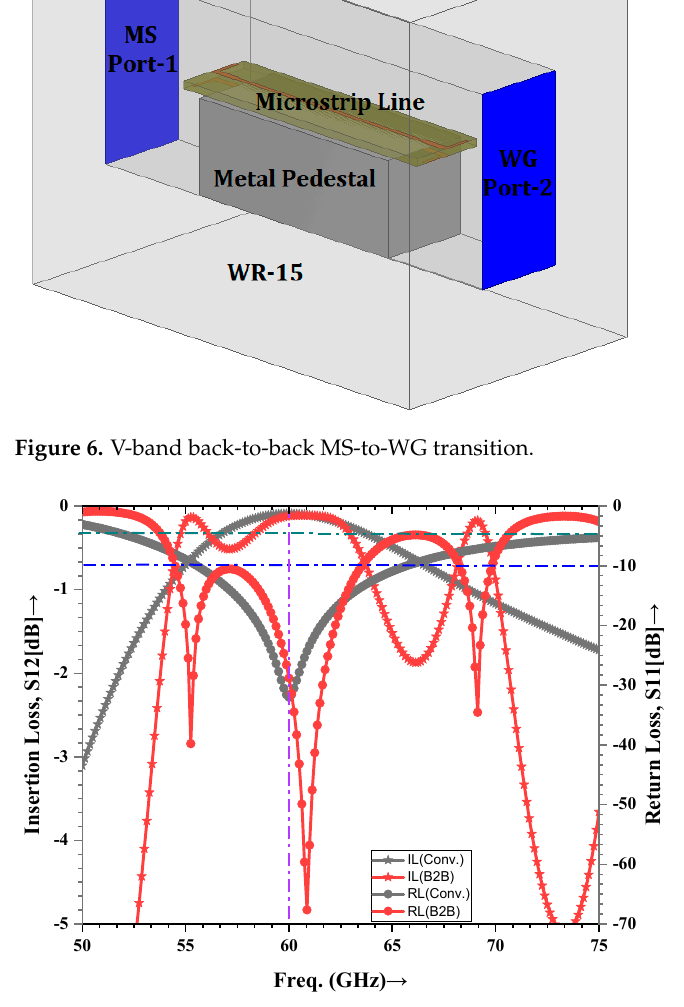
Table 5. Resultant performance parameters of the V-band-designed MS-to-RWG transitions.